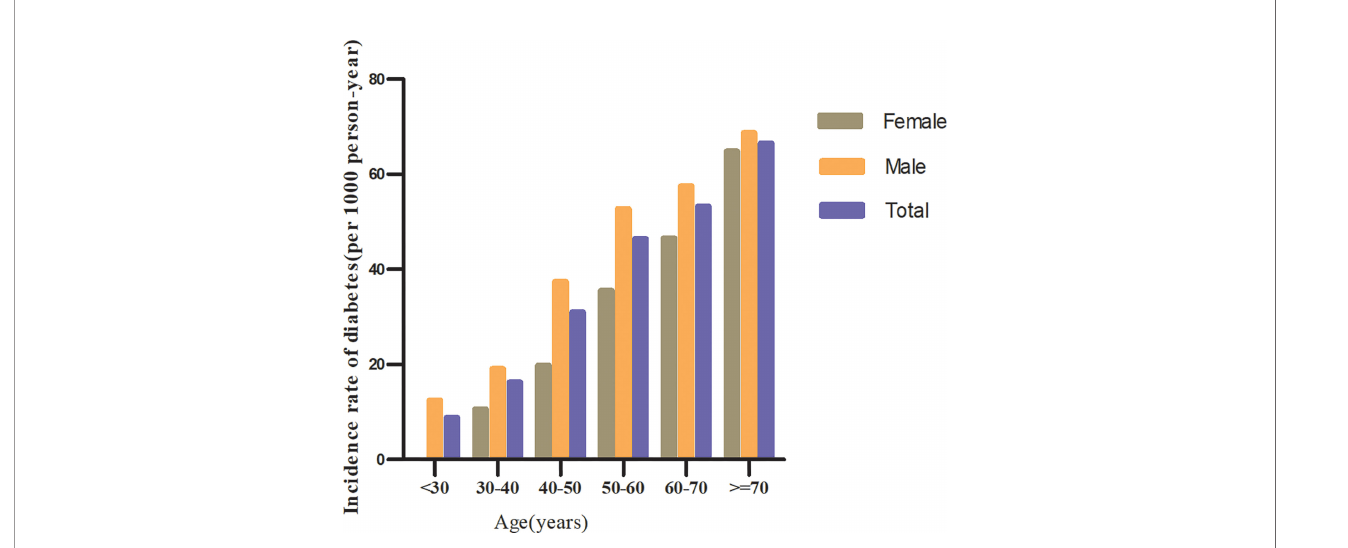
FIGURE 4 | The incidence of diabetes (per 1,000 person-years) in prediabetic patients of age strati fi cation by 10